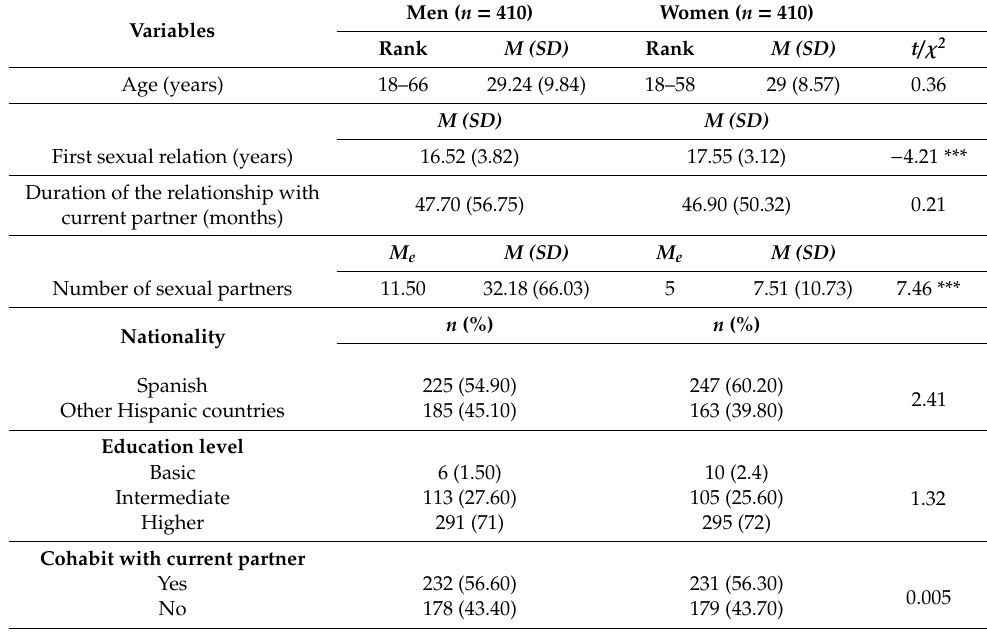
Table 1. Sociodemographic characteristics of the participants ( n =